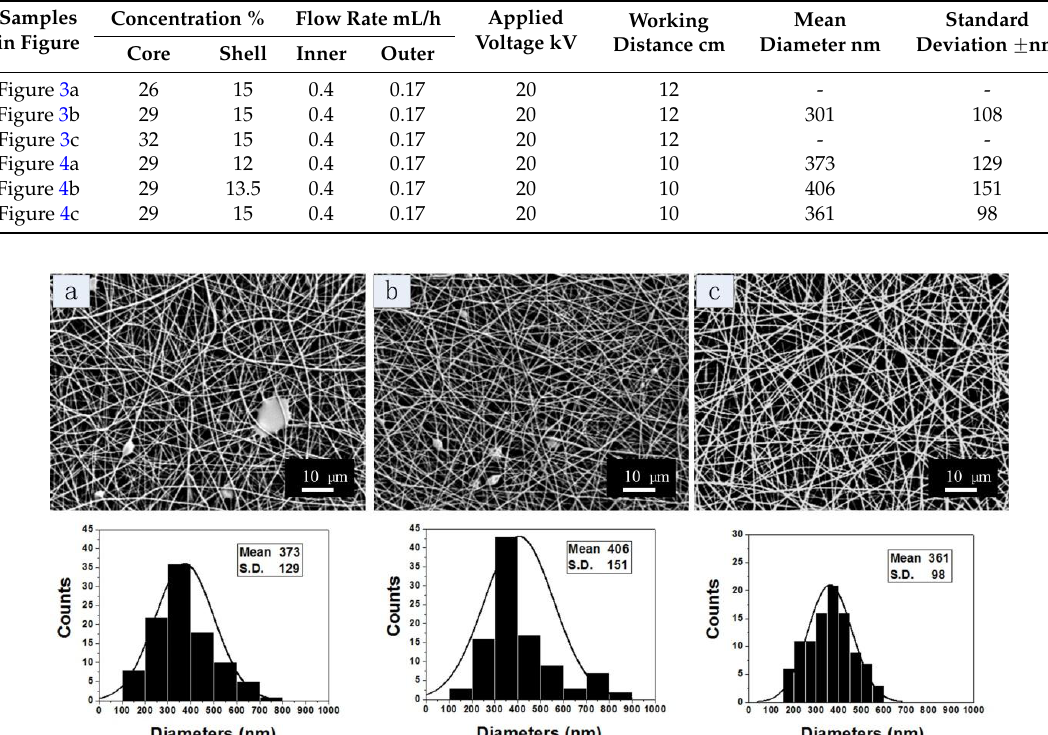
Figure 4. SEM images of coaxial electrospun SF-SELP nanofibers with various SELP concentrations: ( a ) 12 wt % ( b ) 13.5 wt % ( c ) 15 wt %. The concentration of SF solution was 29%. The inner flow rate was 0.4 mL/h, the outer flow rate 0.17 mL/h, the tip to collector distance 10 cm and the applied voltage 20 kV. Table 1. Process parameters and statistical analysis of nanofiber diameters obtained from the field emission scanning electron microscopy (FE-SEM) images (sample size N = 100).